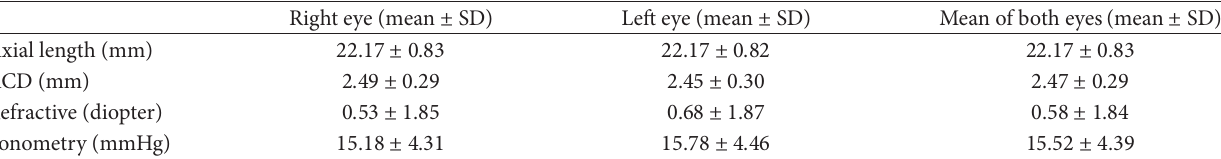
Table 2: Clinical features of PAC subjects.